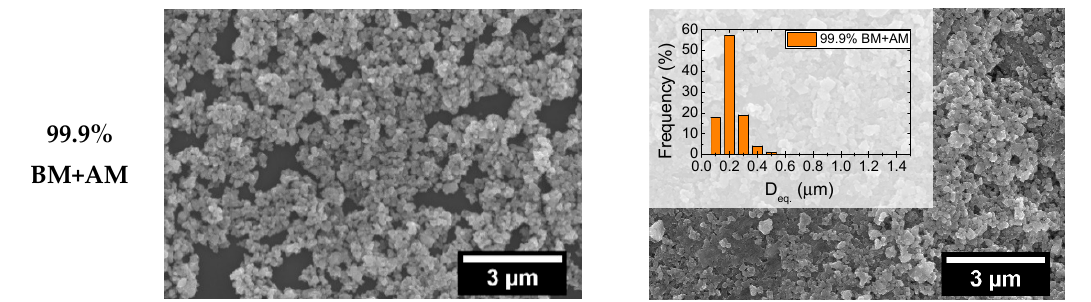
Figure 1. Scanning electron microscopy (SEM) micrographs of different K 0.5 Na 0.5 NbO 3 (KNN) powders and pressed compacts with the respective particle size distribution, highlighting the dissimilarities in particle size.